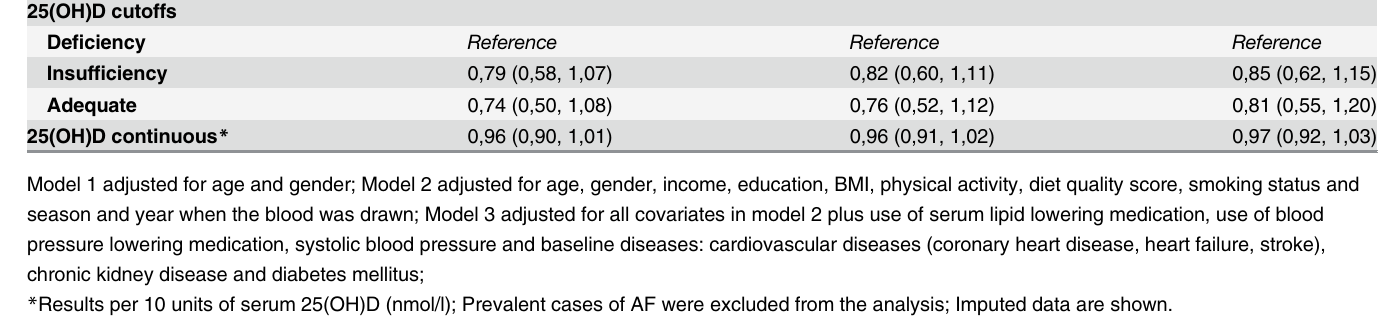
ficient levels: 0.82, 95%CI: 0.60 – 1.11, HR for adequate levels: 0.76, 95%CI: 0.52 – 1.12) (Table 2). Additional adjustment for potential mediators did not change the results (Table 2). We tested the interaction of serum 25(OH)D with gender, age, current smoking and use of BP lowering drugs. None of the interaction terms entered in the model were statistically signifi- cant. We also performed stratifications based on these covariates, but no significant associa- tions were seen in these strata (data not shown). Additional adjustment for serum calcium did not change the results (data not shown). We also tested for the interaction between serum cal- cium and serum 25(OH)D but this was also not significant (data not shown). Excluding partic- ipants with hypercalcaemia did not change the results significantly (data not shown).